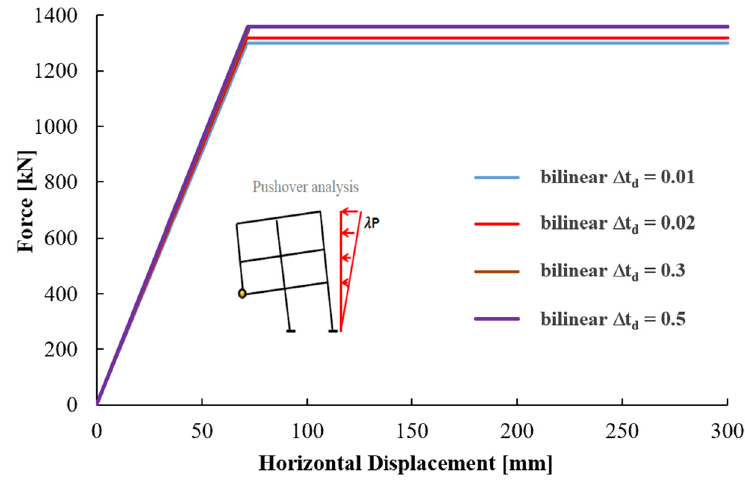
19 Figure A3. Displacement of the node at the top of column 3: effect of variation of Δ t d (removal time of the column). Δ t d values are expressed in seconds. Figure A4 shows the results of the pushover analyses for location 1 with damage level equal to 1 (column 3 removed) and how the variation of Δ td affects the capacity of the